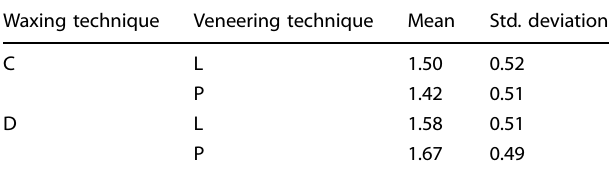
Table 3. Descriptive statistics for mean microleakage